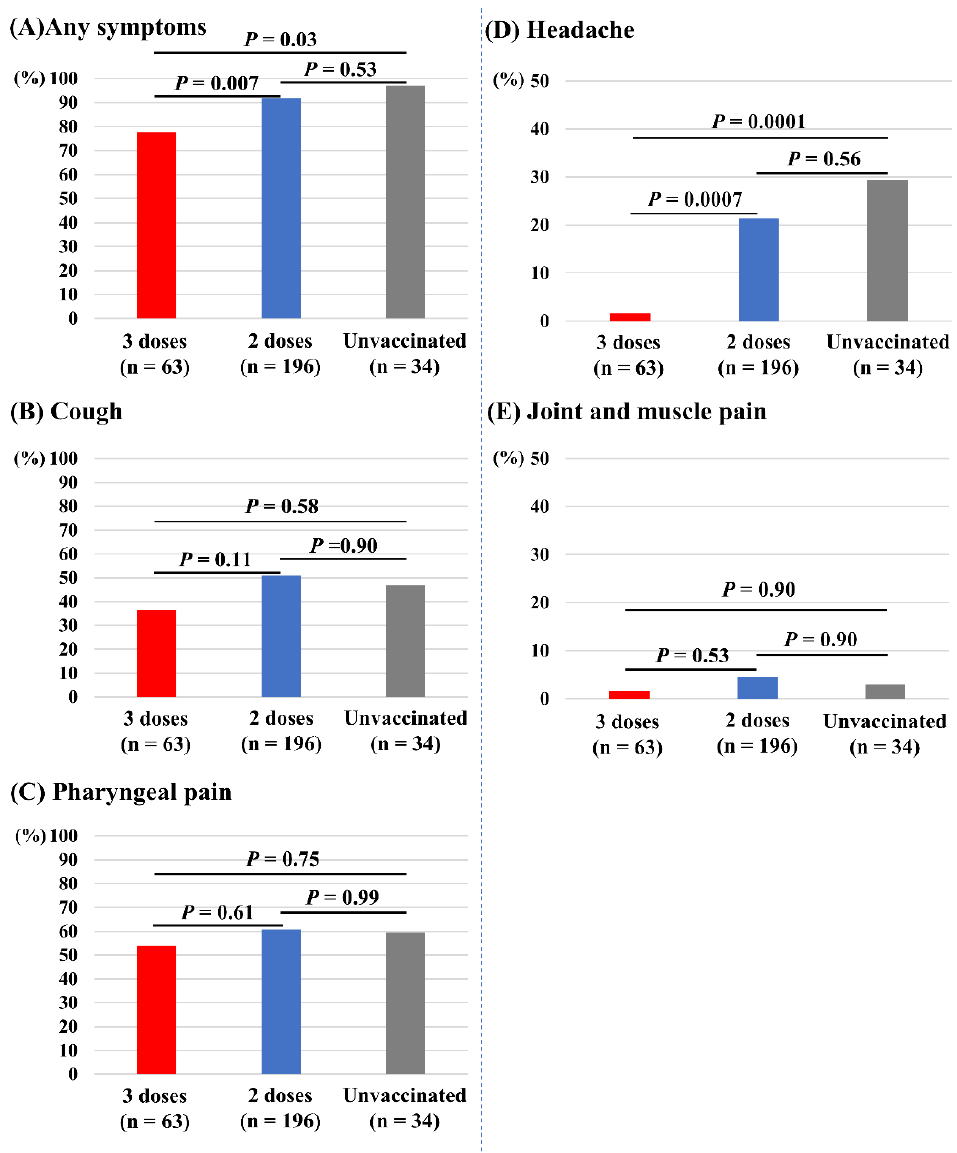
Figure 4. Associations of vaccine doses and symptoms other than fever. ( A ) Any symptoms. ( B ) Cough. ( C ) Pharyngeal pain. ( D ) Headache. ( E ) Joint and muscle pain. ( B ) Cough. ( C ) Pharyngeal pain. ( D ) Headache. ( E ) Joint and muscle